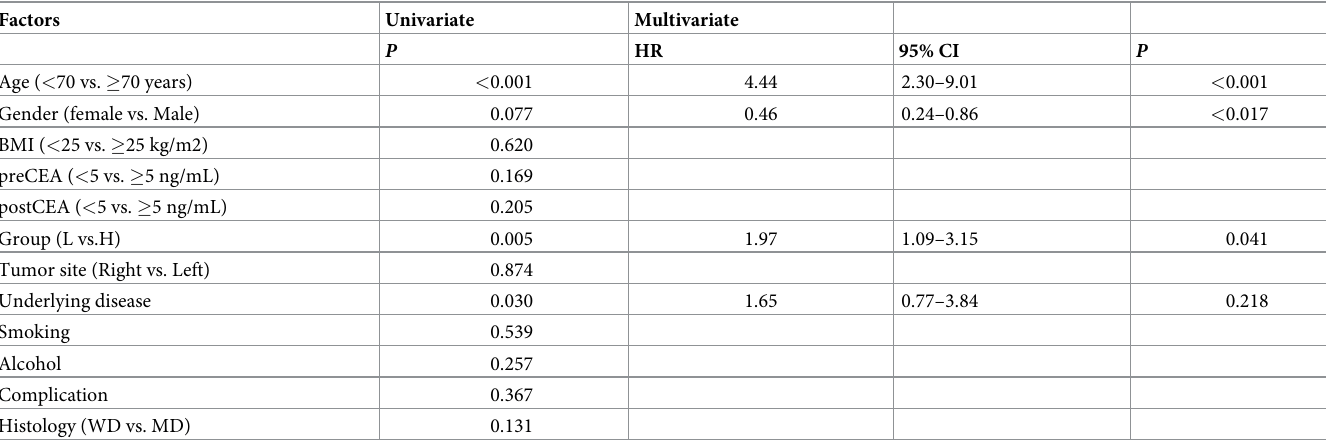
Table 6. Uni- and multivariate analysis of risk factors associated with mortality using Cox regression